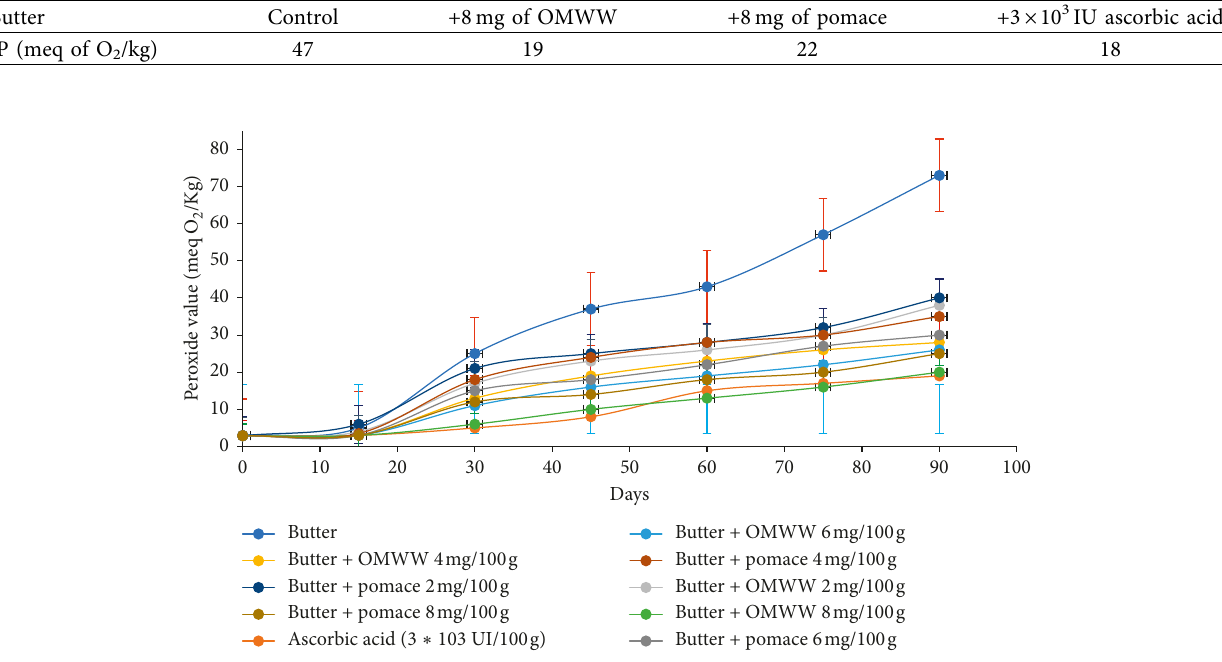
Figure 7: Evolution of the peroxide value as a function of the storage time of butter at 60 ° C. Table 4: Butter peroxide value at 90 days storage at 60 °